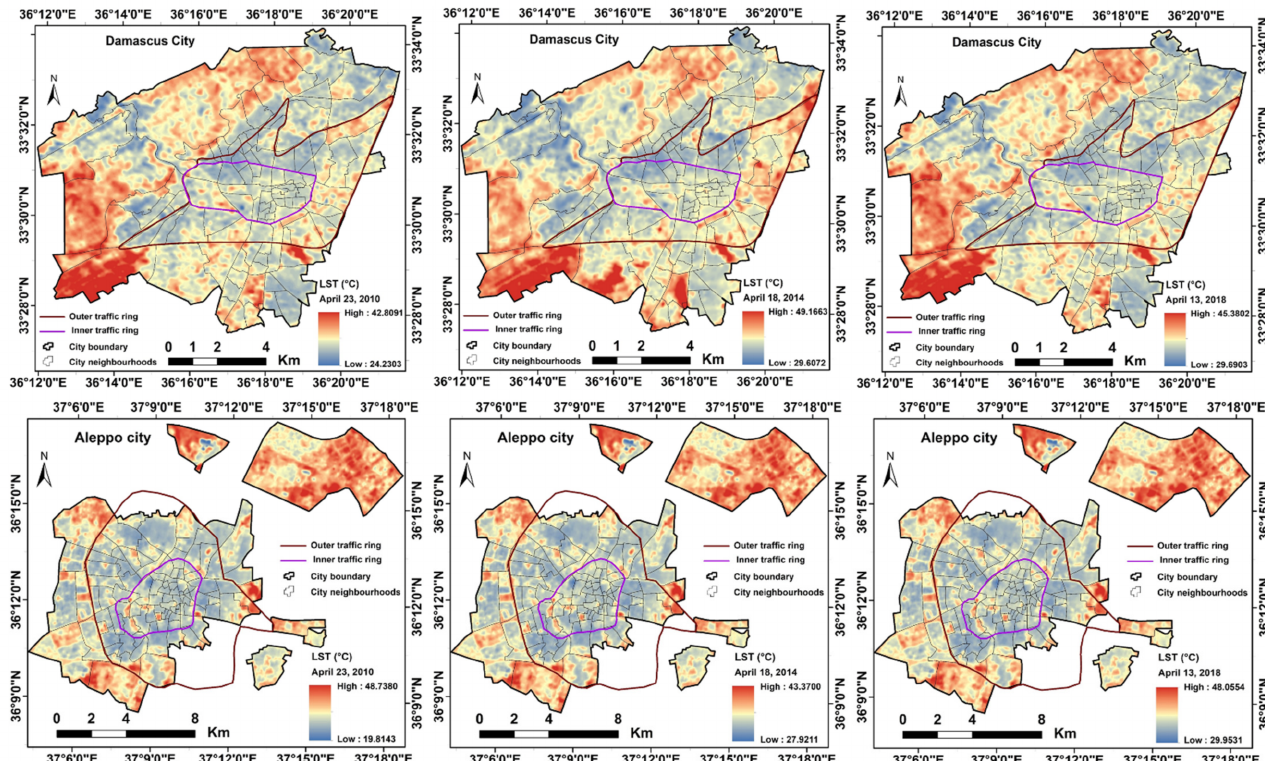
Figure 5. Spatial distribution of LST in Damascus and Aleppo between 2010 and